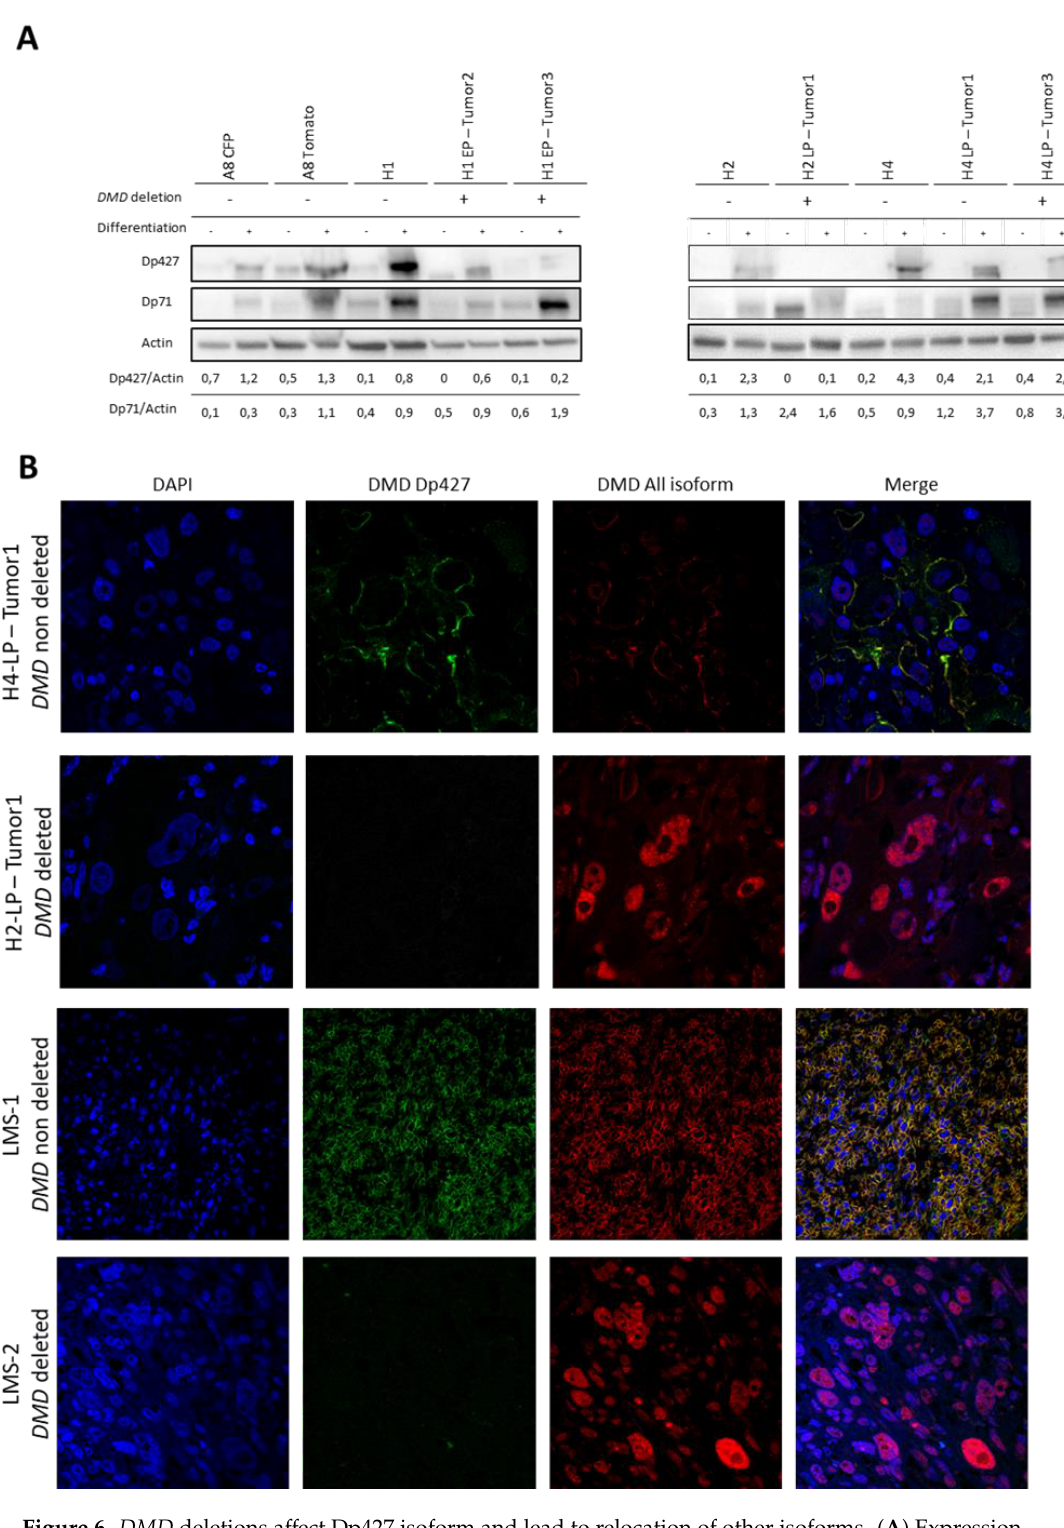
Figure 6. DMD deletions affect Dp427 isoform and lead to relocation of other isoforms. ( A ) Expression of Dp427 and Dp71 dystrophin isoforms by western blotting analysis in proliferation (−) or muscular differentiation (+) conditions. DMD deletion is indicated for each sample; −: DMD non deleted; +: DMD deleted. ( B ) Detection of Dp427 and other dystrophin isoforms by immunofluorescence analysis. Green fluorescence corresponds to Dp427 isoform, red to all dystrophin isoforms and blue is DAPI to detect nucleus.